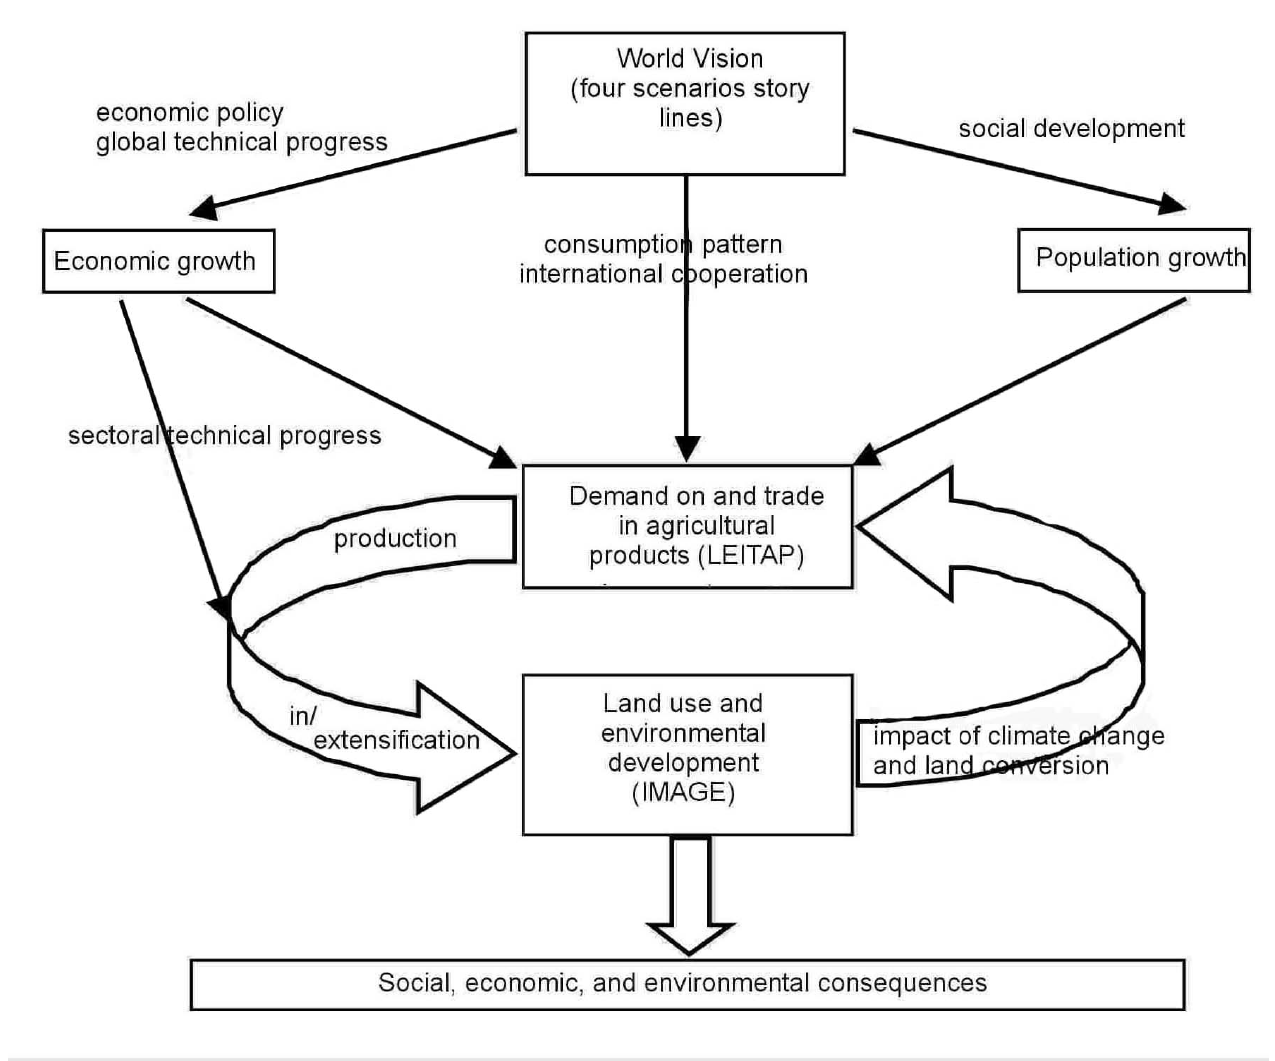
Fig. 1 . Methodology of model interaction between LEITAP and IMAGE (source MNP